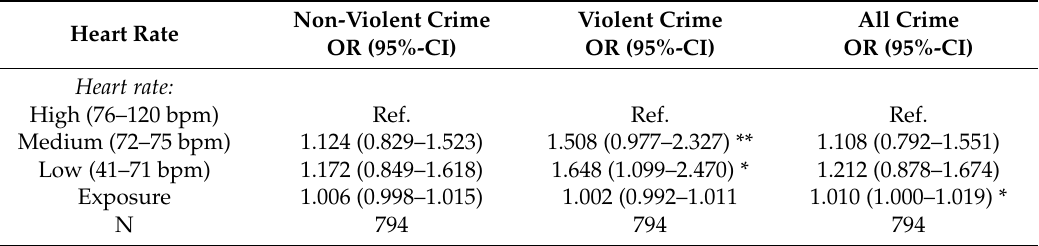
Table 3. Logistic regression analyses predicting offspring criminal behavior.